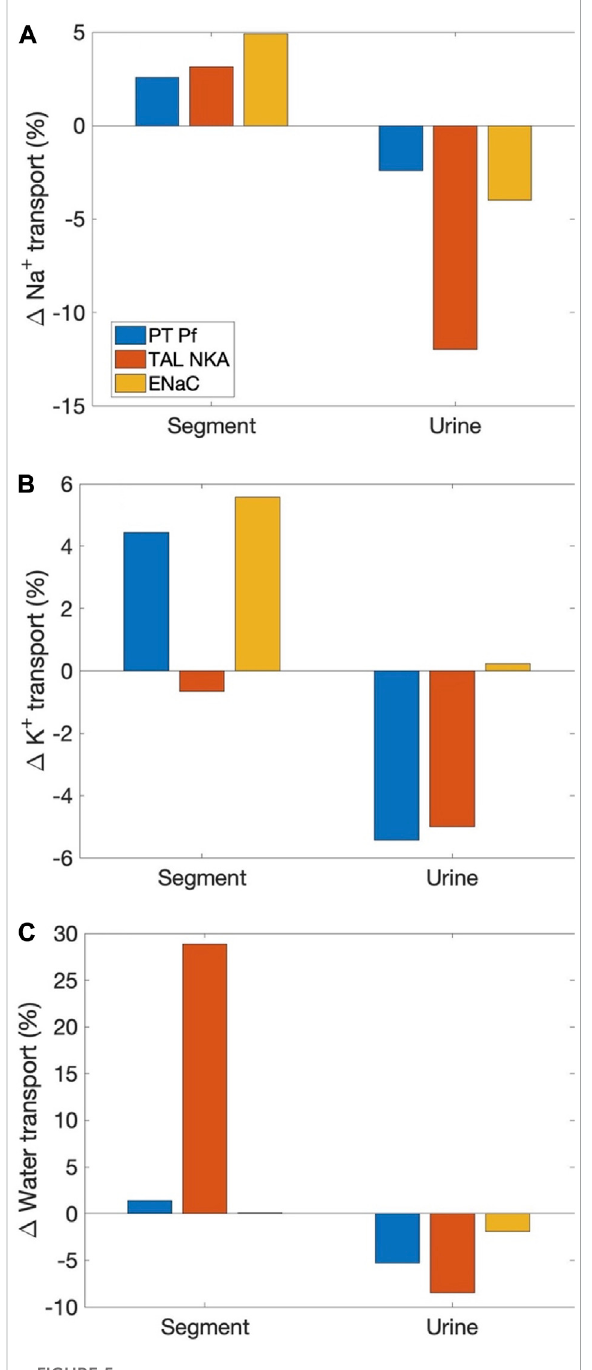
Effects on segmental transport and urinary excretion in the female mouse if selected sex differences in mice were change to correspondingdifferencesintherat.Threesexdifferencesthatare most qualitatively different between the two species were considered: 1) proximal tubule apical water permeability ( “ PT Pf ” ), 2) thick ascending limb Na + -K + -ATPase ( “ TAL NKA ” ), and 3) ENaC. Results show fractional changes in Na + transport (A) , K + transport (B) ,and water transport (C) along affectedsegments, as wellas the corresponding changes in urinary excretion rates and